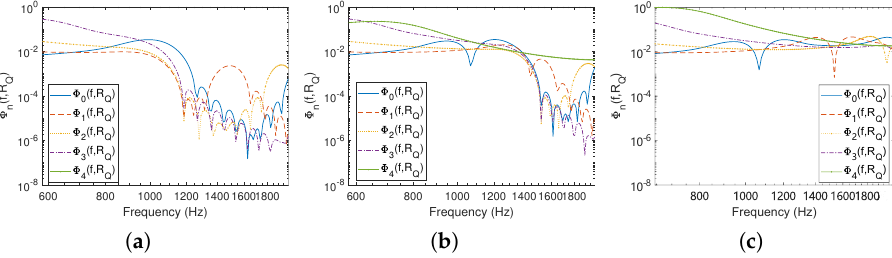
Figure 2. Frequency response of up to 4-th order of the pre-designed order dependent FIR filter ρ n ( ν , R Q ) with z n ( ν ) frequency truncated at ( a ) f 1 , ( b ) f 2 ( c ) f 3